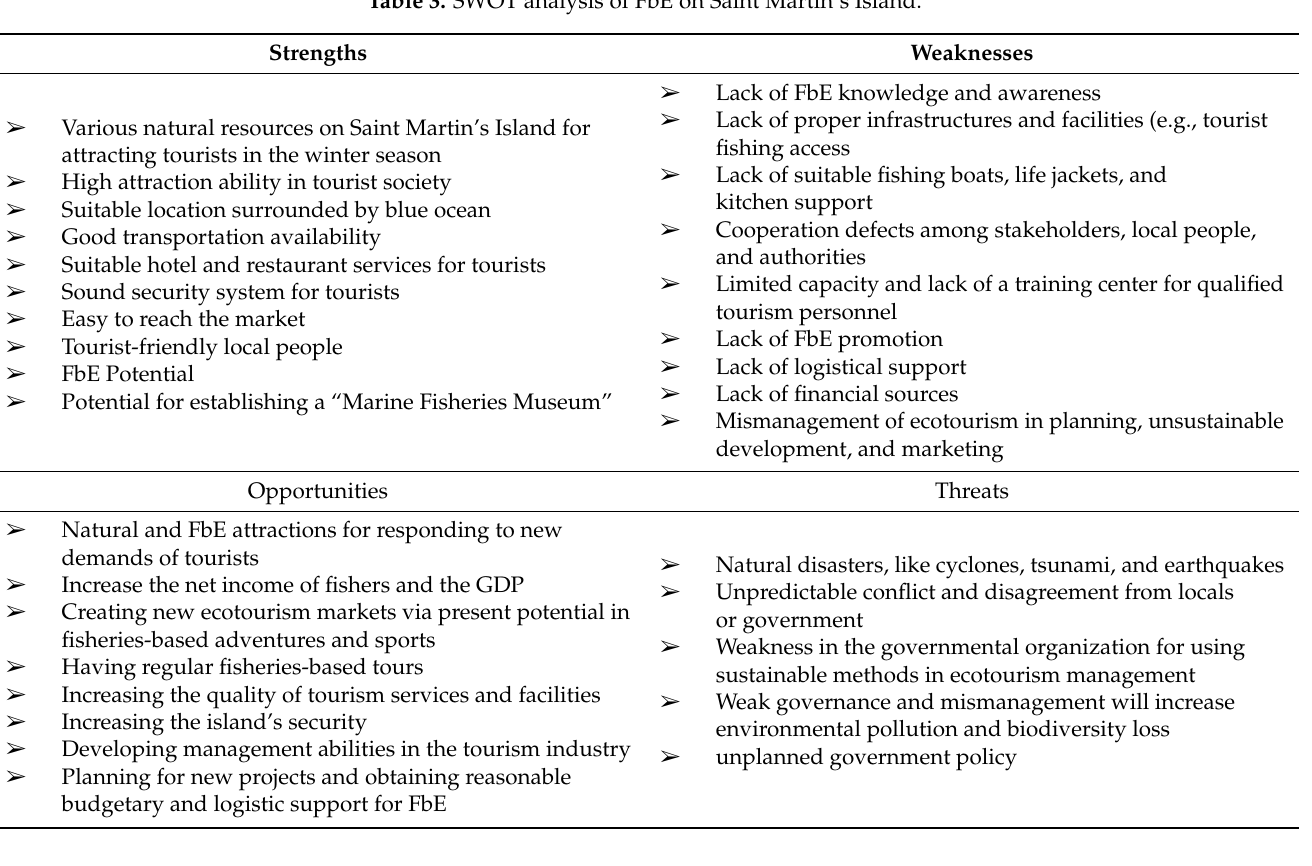
Table 3. SWOT analysis of FbE on Saint Martin’s